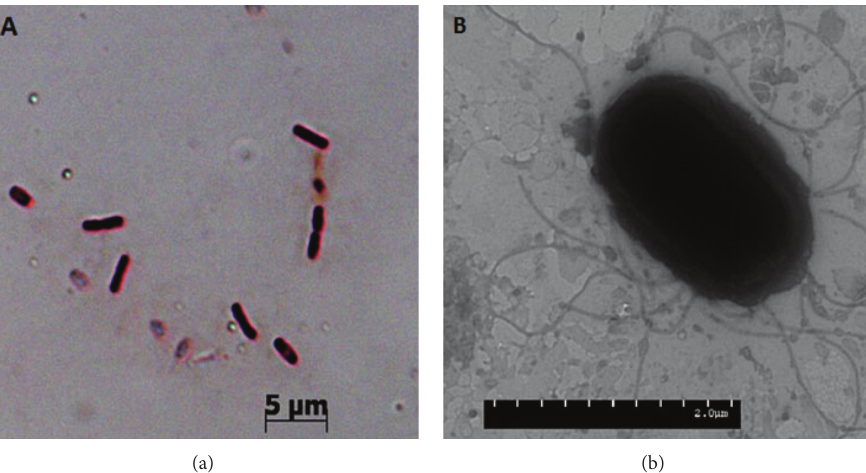
Figure 3: Morphology of Bacillus subtilis strain B37. (a) Rod-shaped cells of strain B37. (b) Flagella on a bacterial cell of strain B37 (the photo was taken with TEM at the Life Science Laboratory Center of Nanjing Agriculture University, China).